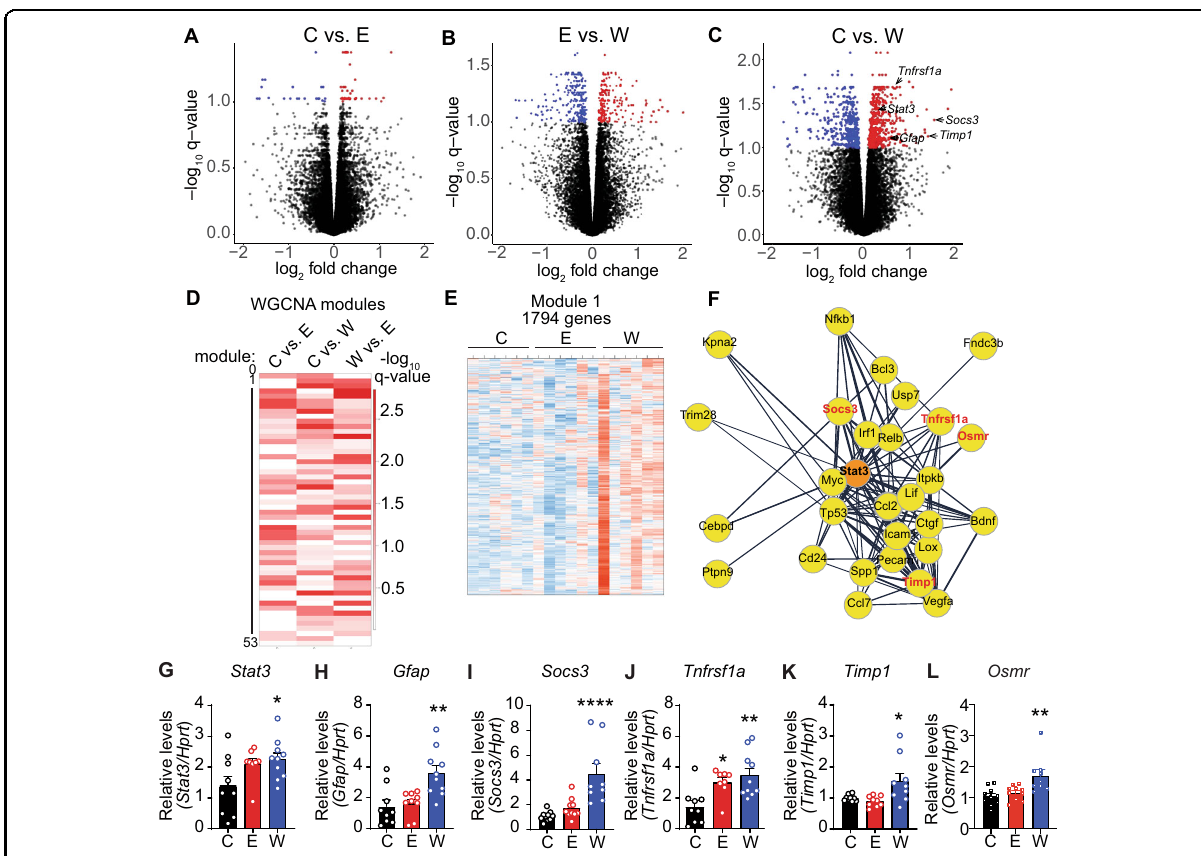
Fig. 1 Increased expression of Stat3 and its transcriptional target genes in the hippocampus of ethanol withdrawn rats after chronic exposure. Rats were fed control liquid diet (C), ethanol liquid diet (E), or ethanol liquid diet followed by 24 h of withdrawal from ethanol diet (W). The dorsal hippocampus was dissected and RNA isolated and subjected to RNA sequencing (RNA-Seq, n = 6) or qPCR ( n = 10). A – C Volcano plots of genes differentially expressed between ( A ) C and E, ( B ) E and W, and ( C ) C and W by RNA-Seq. Red and blue dots indicate genes that were increased and decreased, respectively, in each comparison with q ≤ 0.1. D Heat map of 53 modules identi fi ed by weighted gene coexpression network analysis (WGCNA) with eigengene q -values ( − log 10 ) in C vs. E, C vs. W, and W vs. E comparisons. E Heat map showing expression of 1794 genes in module 1 in C, E, and W conditions. Each column is from an individual rat. Blue and red indicate decreased and increased expression levels, respectively. F Cytoscape plot of STRING protein – protein interaction analysis showing a module 1 cluster with the fi rst shell of interactors with STAT3. G – L Relative expression by qPCR of ( G ) Stat3 , ( H ) Gfap , ( I ) Socs3 , ( J ) Tnfrsf1a , ( K ) Timp1 and ( L ) Osmr in C, E, and W conditions. Data are presented as the mean ± SEM. * p < 0.05, ** p < 0.01, and **** p < 0.0001 by Tukey ’ s test after one-way